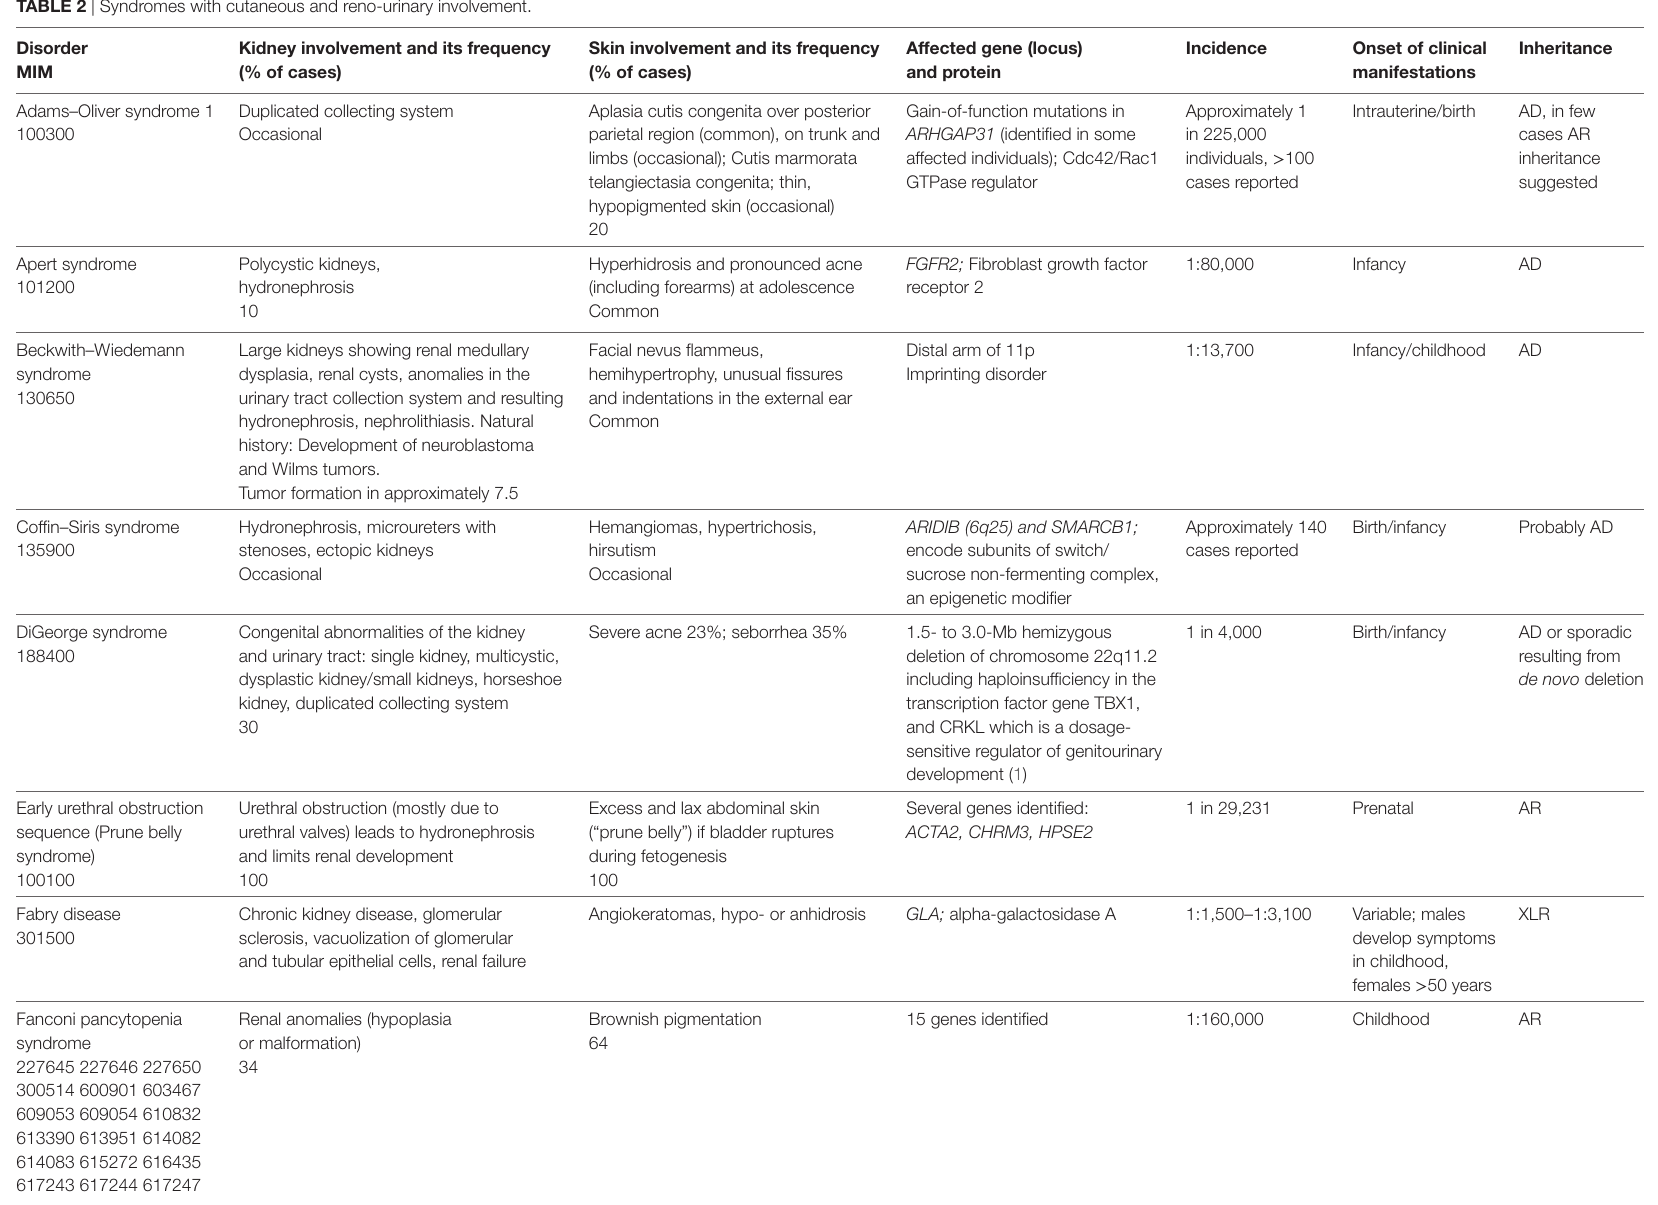
TABLe 2 | Syndromes with cutaneous and reno-urinary